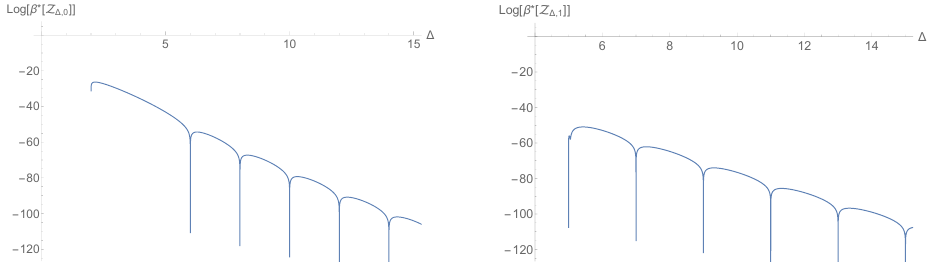
Figure 12. The extremal functional (cid:12) (cid:3) acting on spin-0 (left) and spin-1 (right) primaries at c = 24 and (cid:1) t =